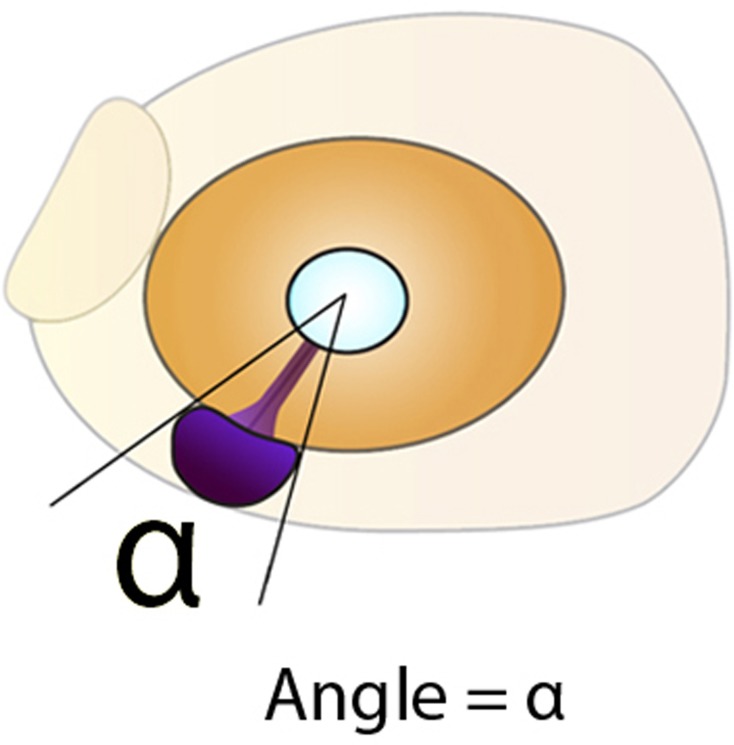
Measurement of angle in embryos stained for pax2a at 36 hpf, in lateral view.